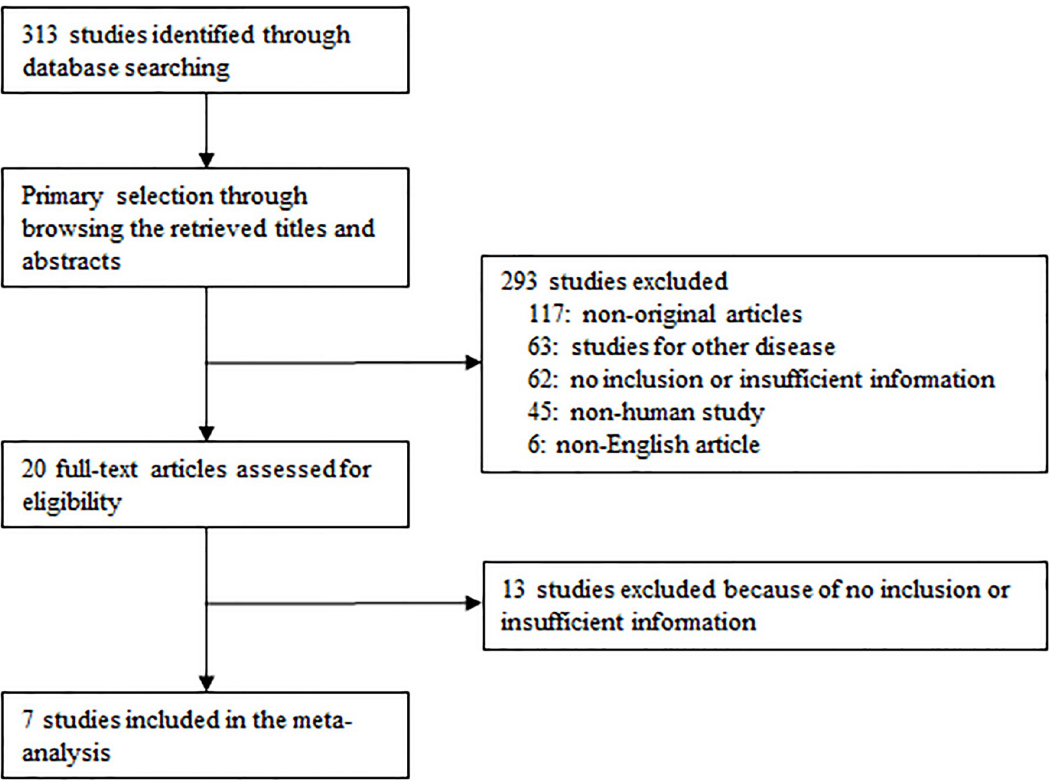
Fig 1. Flow of information through the different phases of the eligible